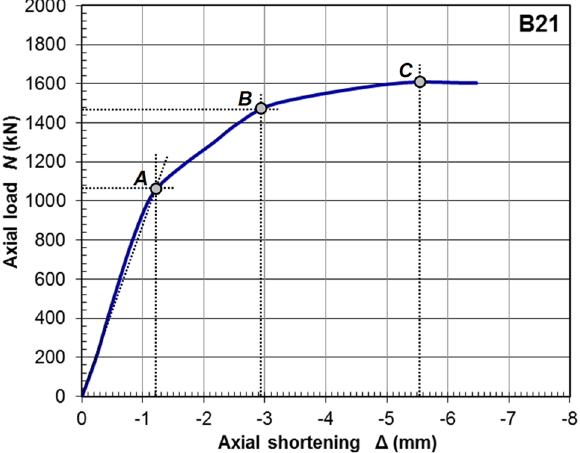
Figure 11. Typical axial force versus deformation curves for strengthened columns.